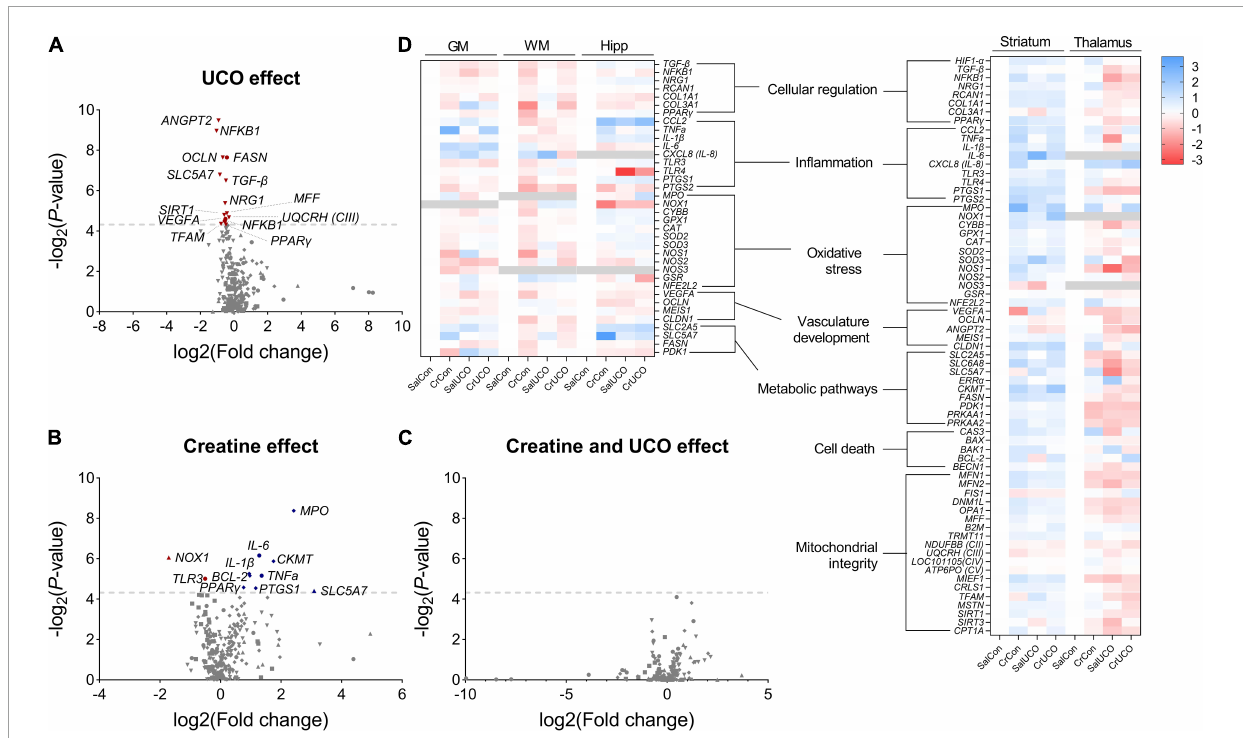
FIGURE1 Volcano plot visualizations of (A) umbilical cord occlusion (UCO) and (B) creatine main effects, and (C) SalUCO vs. CrUCO post-hoc comparisons. Volcano plots show fold change [log 2 (fold change); i.e., log 2 (fold change = 2) = 1; x-axis] and all gene expression changes [ − log 2 (adjusted P -value); y axis] in all brain regions: GM ( • ), WM ( (cid:4) ), hippocampus ( (cid:78) ), striatum ( (cid:7) ) and thalamus ( (cid:72) ). Gray dashed line represents a P -value of 0.05 [ − log 10 (0.05) ≈ 4.139]. Names of genes with P < 0.05 are included. Genes that were downregulated are presented in red and those upregulated in blue. (D) Heat map representation of gene expression determined by reverse transcription-quantitative polymerase chain reaction (RT-qPCR)